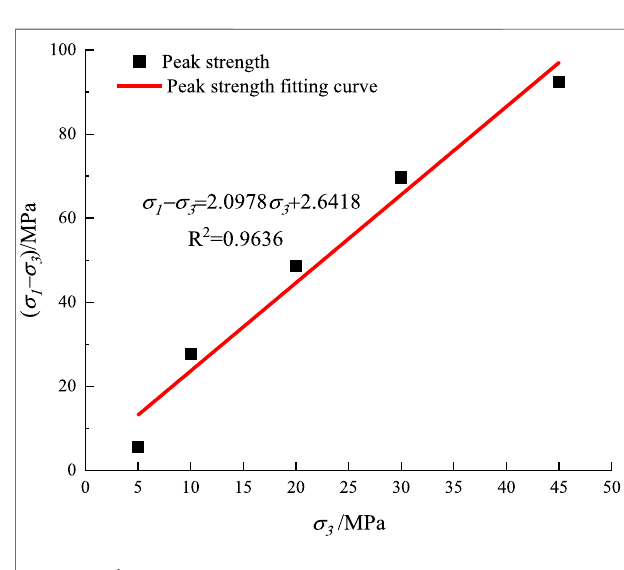
FIGURE 5 | Peak stress of sandstone under conventional triaxial